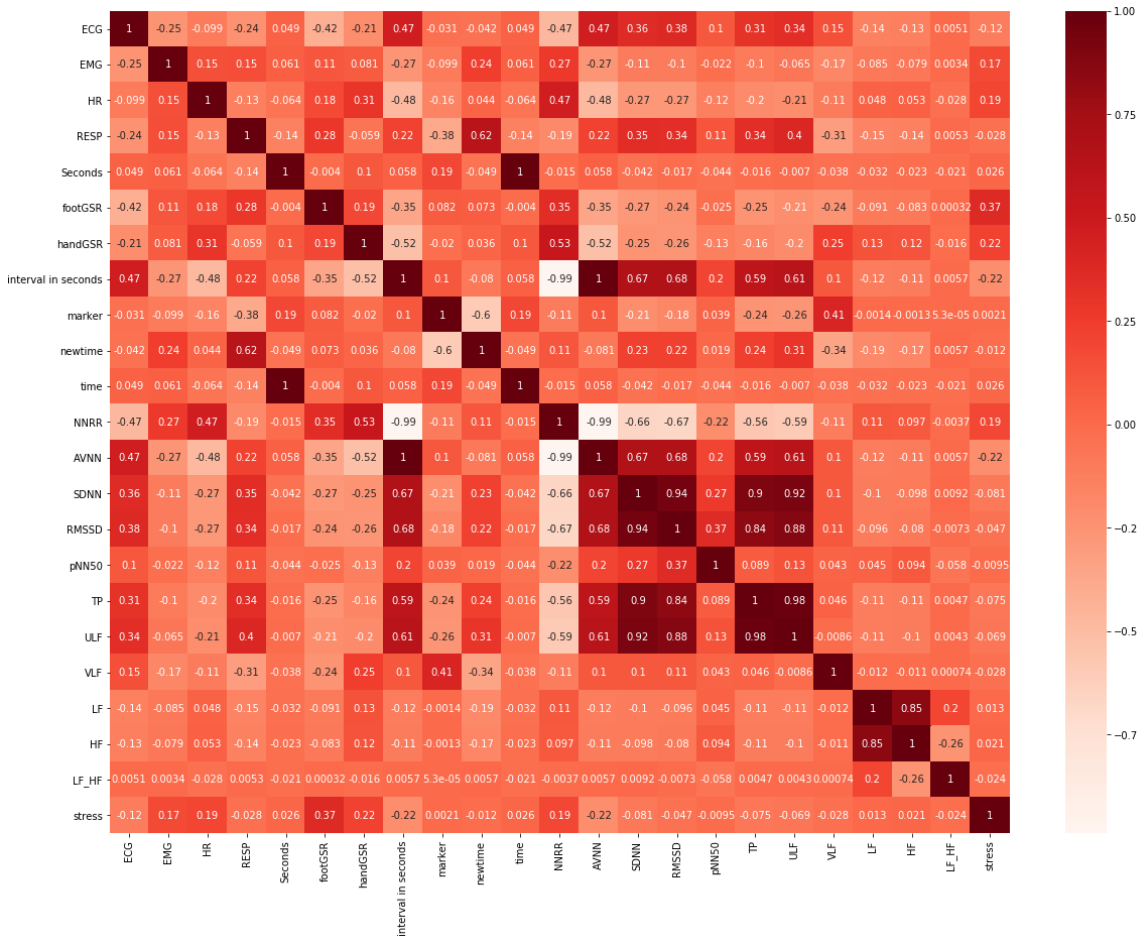
Table 2. RFE feature importance score on original-dataset, the most relevant features have the lowest RFE score.